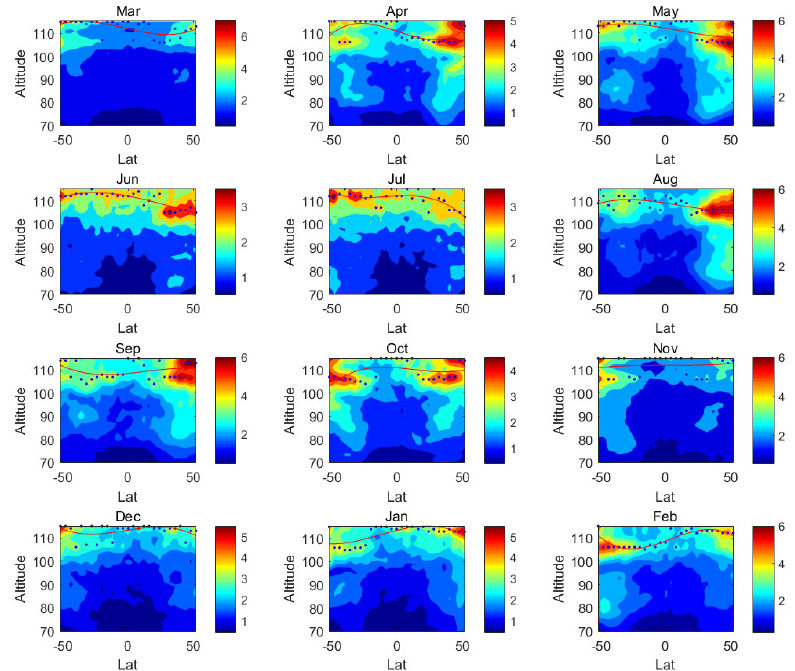
Figure 5. Monthly mean amplitudes of 6.5 DWs (red curved lines are third-order polynomial fitting of the peak height of amplitude at each latitude).